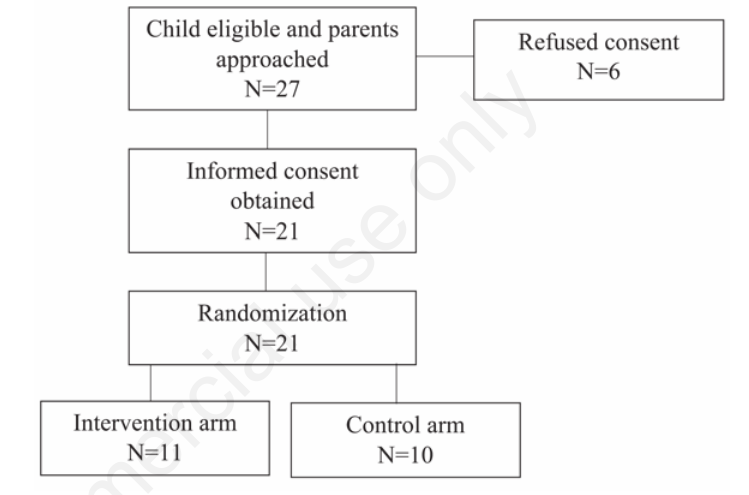
Table 1. Summary of results.